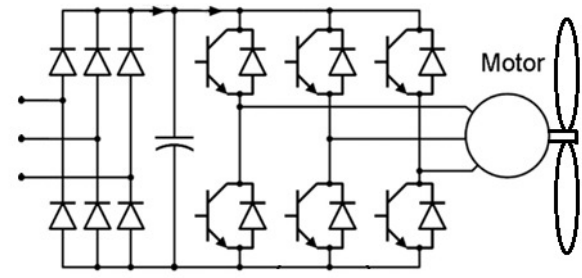
Fig. 1. The proposed system